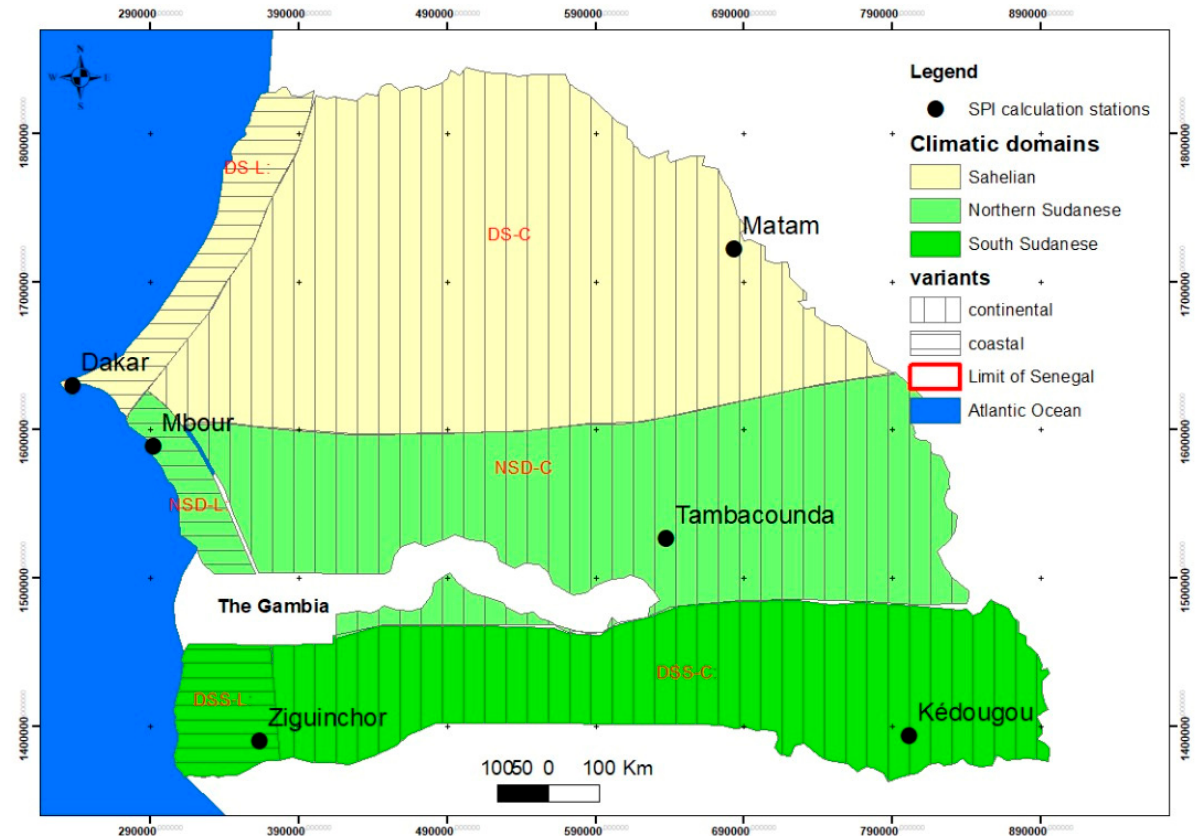
Figure 1. Location map of the study area showing the climatic stations. On average, annual rainfall varies from north to south, from 200 mm (Sahelian domain) to around 1250 mm (southern Sudanian domain [10]. Senegal has, depending on rainfall, three climatic domains: the Sahelian, northern Sudanese, and southern Sudanese domains (Figure 1).